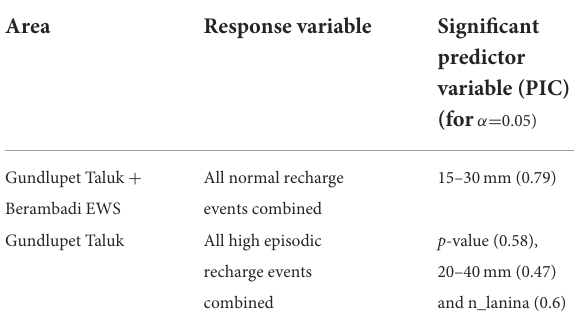
TABLE 3 Results of PIC